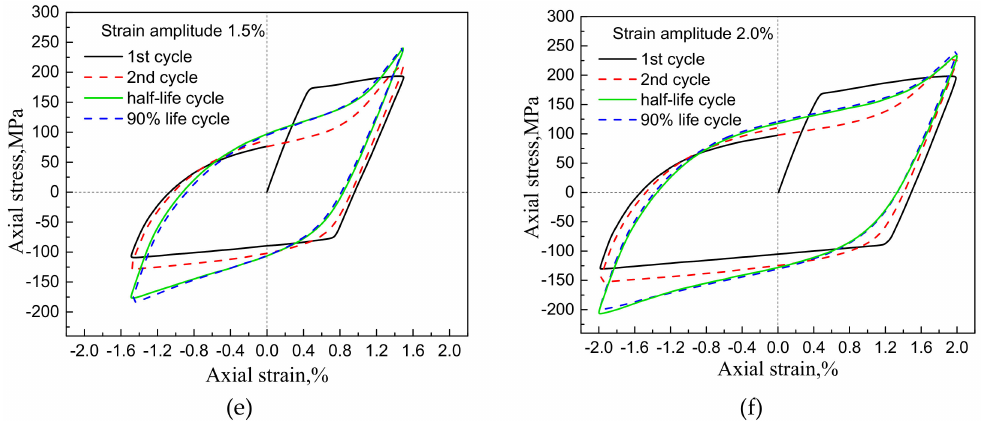
Figure 2. Cyclic hysteresis loops corresponding to di ff erent cyclic numbers at the selected strain amplitudes: ( a ) 0.3%; ( b ) 0.5%; ( c ) 0.8%;( d ) 1.2%;( e ) 1.5%; ( f )